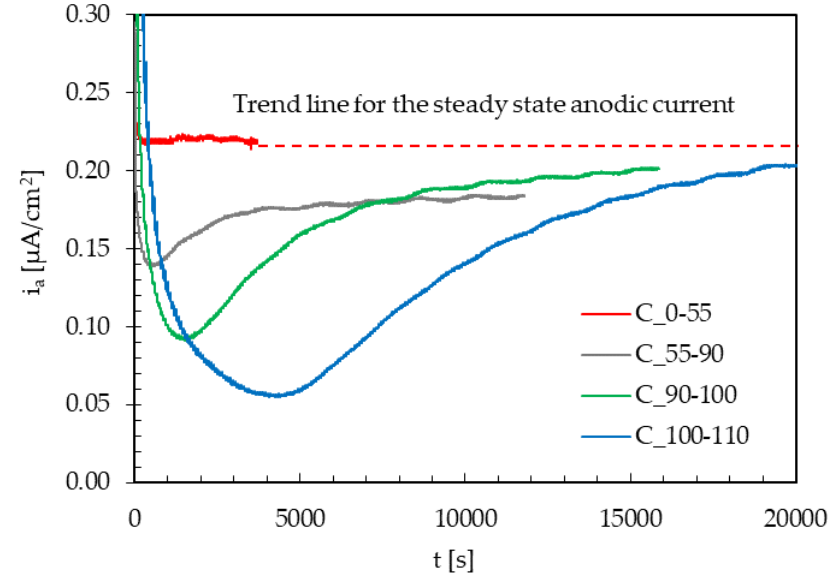
Figure 7. Effect of instant variations of the maximum load (amplitude = ± 10% TYS; frequency = 10 − 2 Hz) on the steady state anodic current (i a, ∞ ).